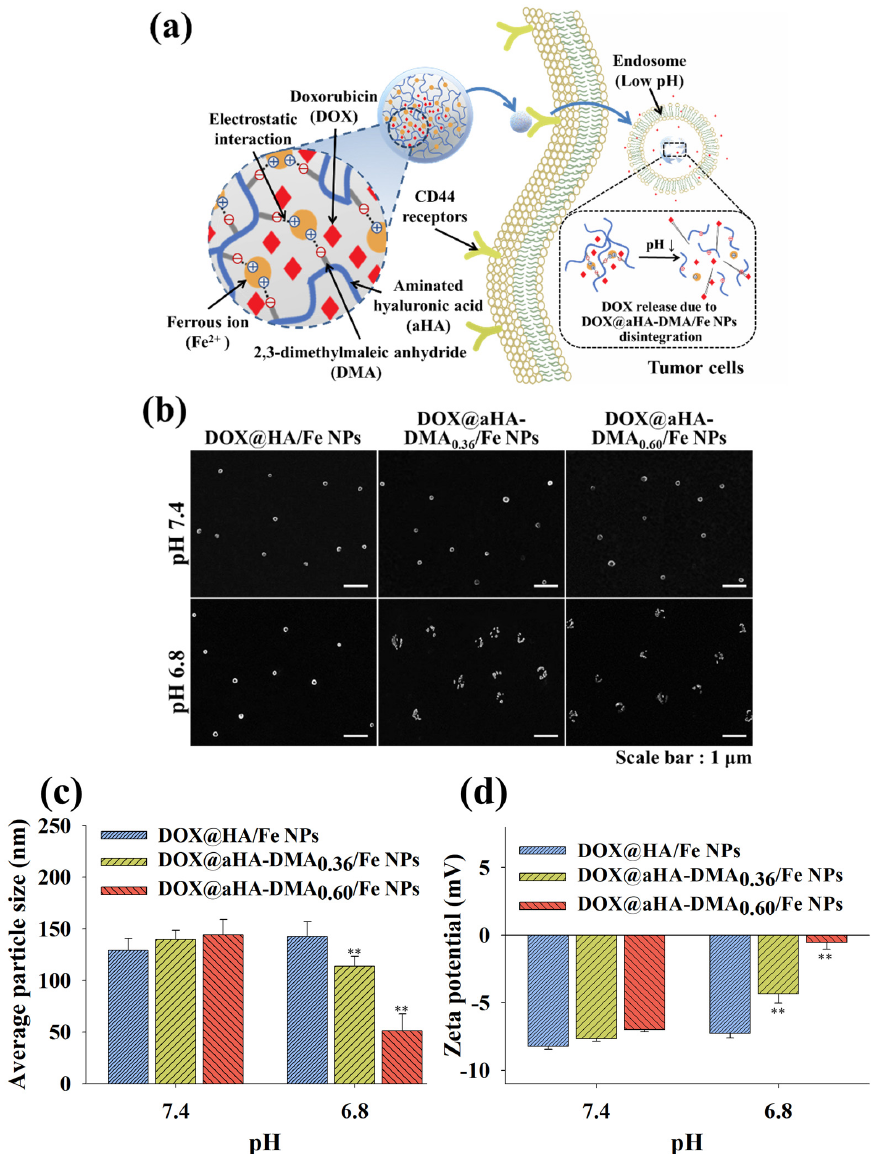
Figure 1. ( a ) Schematic illustration of DOX@aHA-DMA/Fe NPs. ( b ) FE-SEM images of